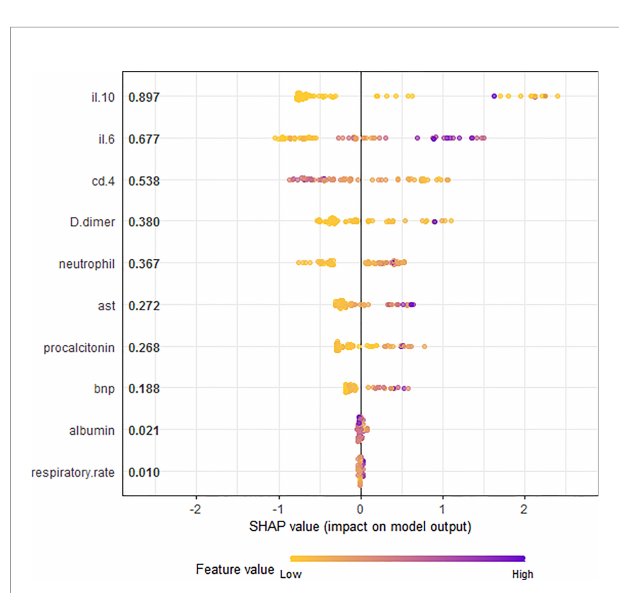
FIGURE 4 | SHAP summary plot for the all the variables contributing to the XGBoost model prediction for critically ill COVID-19 pneumonia patients. This shows the ranking features and their impact on the model output. The horizontal axis shows the corresponding SHAP value of the feature. A positive SHAP value contributes to the prediction of critically ill COVID-19 pneumonia patients and vice